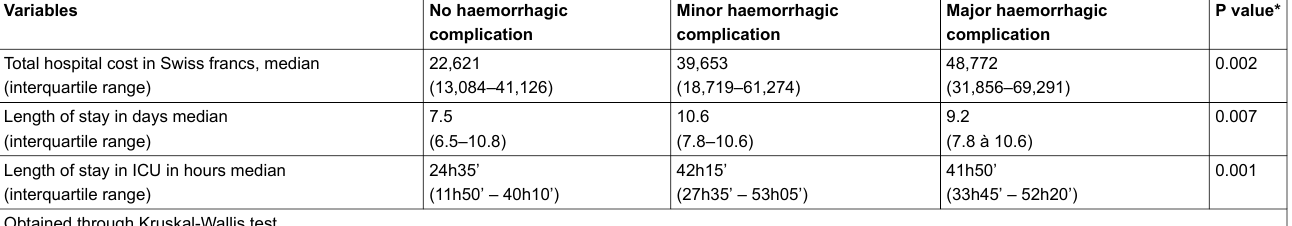
Table 3: Age and sex adjusted median hospital costs. Independent variables associated with hospital